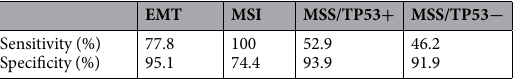
Table 1. Sensitivity and specificity by molecular subtype